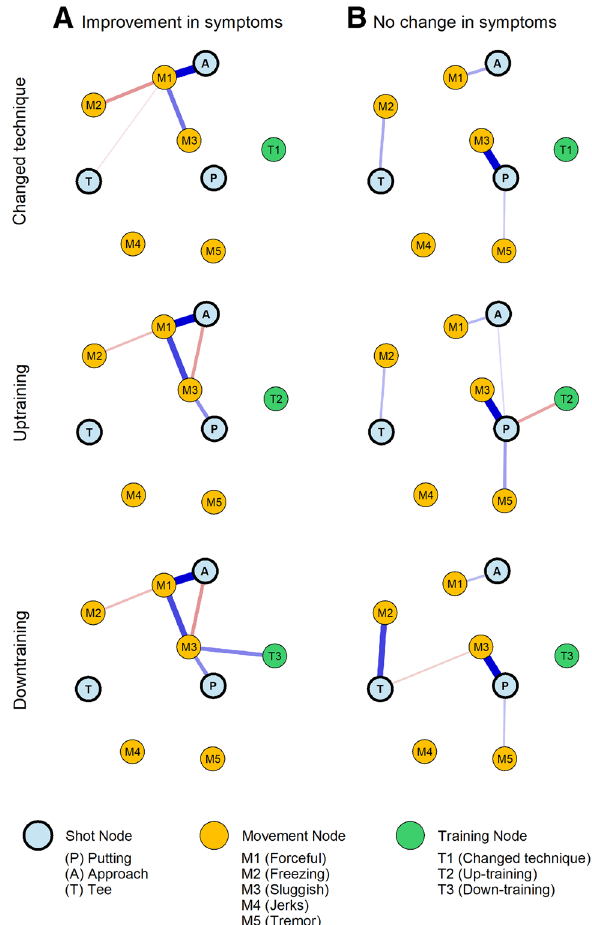
Figure 4. Network plots of outcome of interventions to relieve yips symptoms. In comparison to Fig. 3, the network plots were specified for each strategy that the golfers responded as: ( A ) An improvement in their symptoms or ( B ) No change in their symptoms. Due to the low sample sizes, the network construction was different from Fig. 3 in that (i) Golfers with worsening of symptoms were omitted, (ii) non-zero regression coefficients were specified with ‘OR’ rule, (iii) hyperparameter γ = 0, (iv) Fruchterman–Reingold distance = 1, and (v) network sparsity = 0.83. Network representations were constrained to a fixed ‘X’ and ‘Y’ axis coordinate system for visual comparison purposes. The resulting network showed that approach shots were more pliable for changes in self-administered training adjustments. On the other hand, golfers who reportedly did not show any change in symptoms were mostly with putting type of